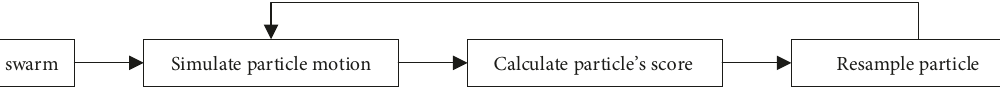
Figure 2: Basic steps of the Monte Carlo localization algorithm.